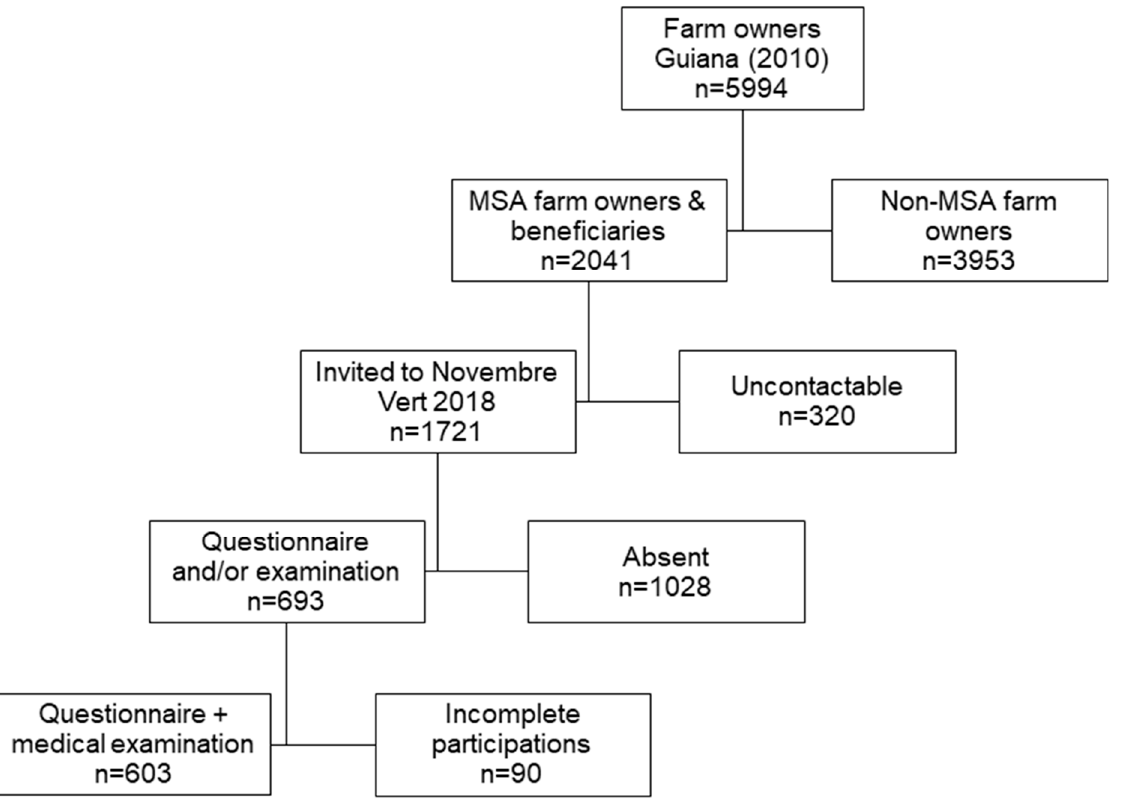
Figure 1. Flow chart of participants included in the study (MSA: Mutualité Sociale Agricole).